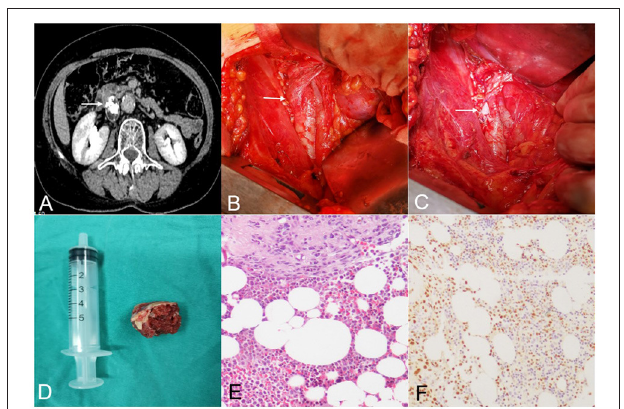
FIGURE 1 | (A) Abdominal CT enhancement scan showed a mixed density image of about 22 * 28mm in the IVC area with calcification and fatty density images [The lesion was indicated by the arrow in (A–C) ]. (B) The mass originated from the wall of the IVC. (C) The mass had been removed, and the inferior vena cava was open and remains to be sutured. (D) The tumor was 2.5cm in size, gray-red in color, solid and hard in texture. (E) Histopathological examination showed that mature bone fragmentation, hematopoietic tissue of bone marrow, and some free wall-like tissues were mainly seen under the microscope. (F) Immunohistochemical test showed positive